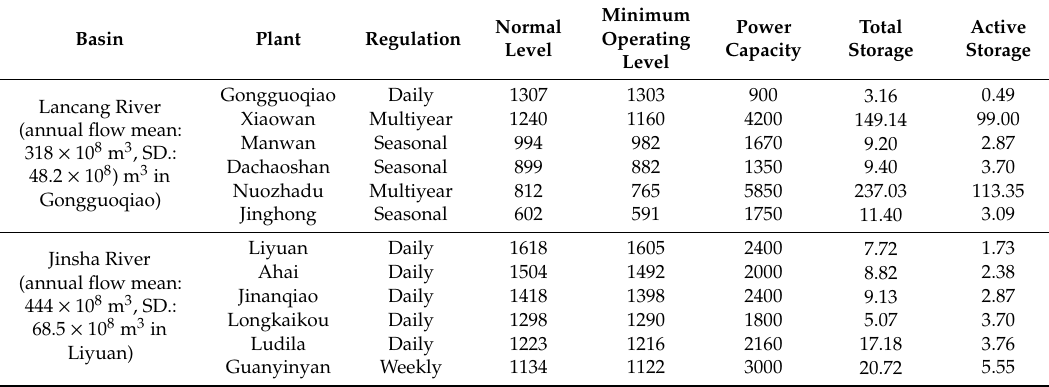
Table 1. Characteristics of hydropower plant cascades (unit, elevation: m, installed capacity: MW, storage: 10 8 m 3